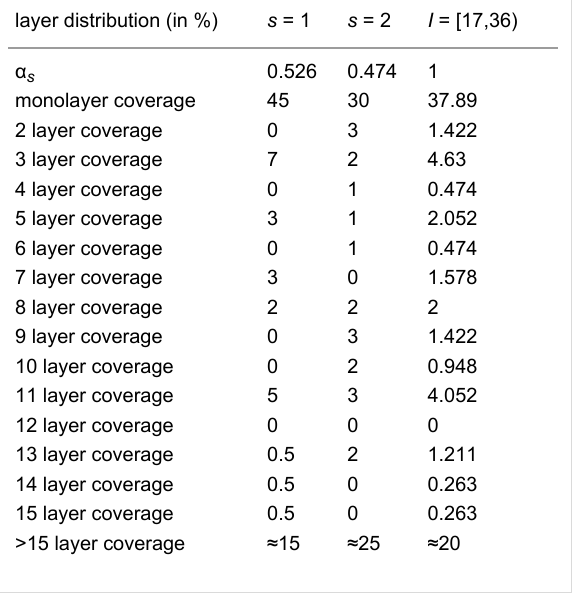
Table 4: Coverage of j -layer GMSE4 graphene regions by the model in Equation